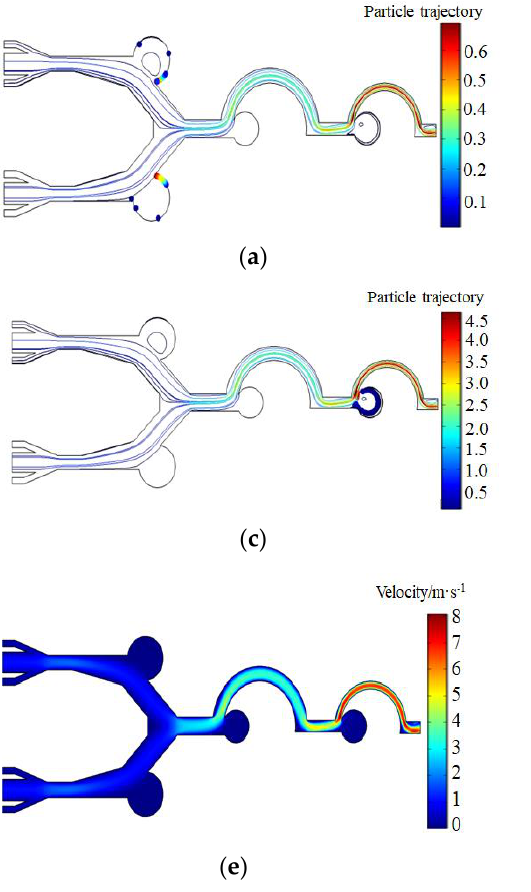
Figure 5. ( a ) Enrichment areas 1a and 1b for 25 μm particles; ( b ) enrichment area 2 for 12 μm particles; ( c ) enrichment area 3 for 5 μm particles; ( d ) exclusion of 2 μm particles from the outlet; ( e ) microfluidic chip channel velocity distribution; ( f ) microfluidic chip pressure distribution.